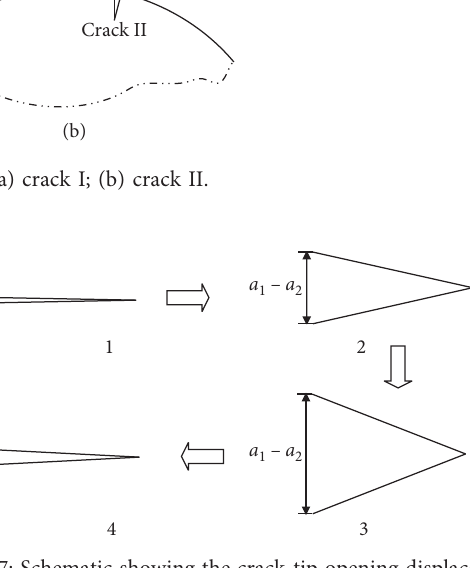
Figure 7: Schematic showing the crack-tip opening displacement in stage-wise fashion for crack III.